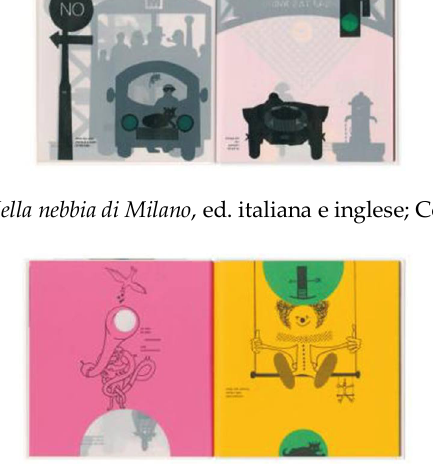
Figure 2. Munari B., Nella nebbia di Milano , ed. italiana e inglese; Corraini, Italia 2008,